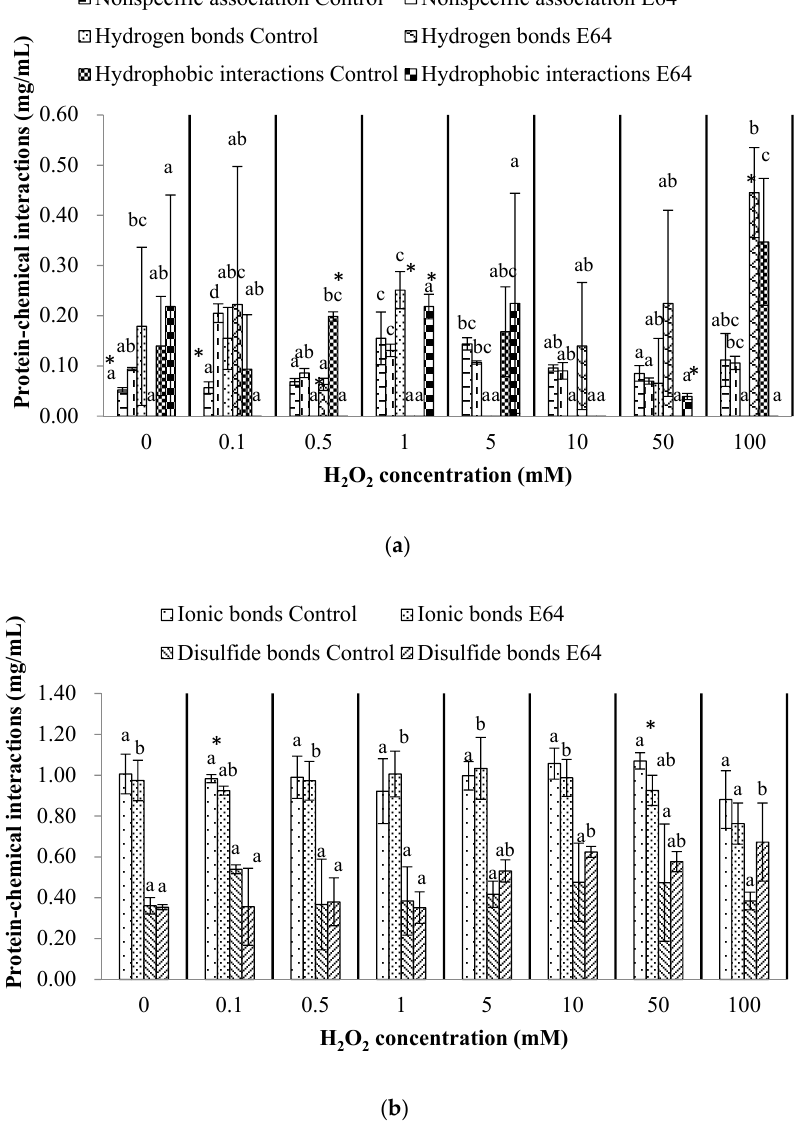
Figure 4. Nonspecific association, hydrogen bonds, and hydrophobic interaction ( a ); ionic bonds and disulfide bonds ( b ) of myofibrillar protein from bighead carps under different H 2 O 2 concentrations. The same lowercase letter indicates no significant differences between samples of the control/E64 group under different H 2 O 2 concentrations. The asterisk indicates significant difference between samples at control and E64 groups under the same H 2 O 2 concentration ( p < 0.05). The ionic bonds, hydrogen bonds, hydrophobic interaction, and disulfide bonds of myofibrillar protein demonstrated dramatic changes to form gels after thermal treatments in Figure 5. The ionic bonds and hydrogen bonds between gel protein molecules almost disappeared after heating. Heat improved the unfolding of the protein structure and re- sulted in the exposure of hydrophobic groups [41]. Liu et al. [42] found that thermal treat- tein gel. Therefore, the hydrophobic interactions and disulfide bonds were the dominant chemical interaction for gels. The hydrophobic interactions of gels in the control group increased significantly from the initial 0 to 0.80 and 0.71 mg/mL at 10 and 50 mM H 2 O 2 , respectively, and then decreased to 0.05 mg/mL at 100 mM H 2 O 2 ( p < 0.05). In addition, the gels of the E64 group demonstrated significantly increased hydrophobic interactions during 0 to 100 mM H 2 O 2 , ranging from 0.70 to 1.51 mg/mL, which were significantly higher than that of control group ( p < 0.05). Correspondingly, the disulfide bonds of the E64 group gels were significantly lower than that of the control group ( p < 0.05). The di- sulfide bonds of E64 gels fluctuated during oxidation, ranging from 0.16 to 0.91 mg/ mL, while the disulfide bonds of control gels increased, firstly, from 0 to 5 mM H 2 O 2 and then decreased to 1.19 and 1.25 mg/mL at 10 and 50 mM H 2 O 2 , respectively, followed by an increase to 1.91 mg/mL at 100 mM H 2 O 2 ( p < 0.05). These results indicated that myofibrillar protein in the control group within cathepsin hydrolysis preferred to form gels with lower hydrophobic interactions and higher disulfide bonds after heating, which was probably because the cathepsin hydrolysis in the control group could lead to more protein degra- dation. Thus, more protein fragmentation was susceptible to hydroxyl radicals and then formed more disulfides; then, the hydrophobic interactions, another dominant chemical force, were less.